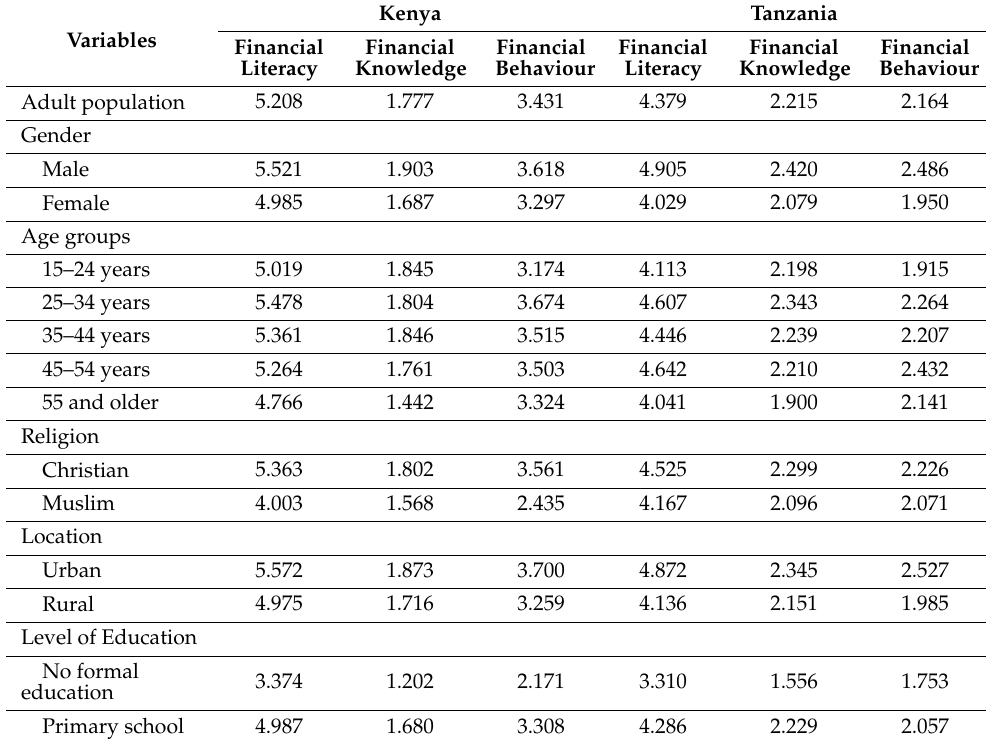
Table 1. Comparison of key parameters of financial literacy in Kenya and Tanzania (mean values).